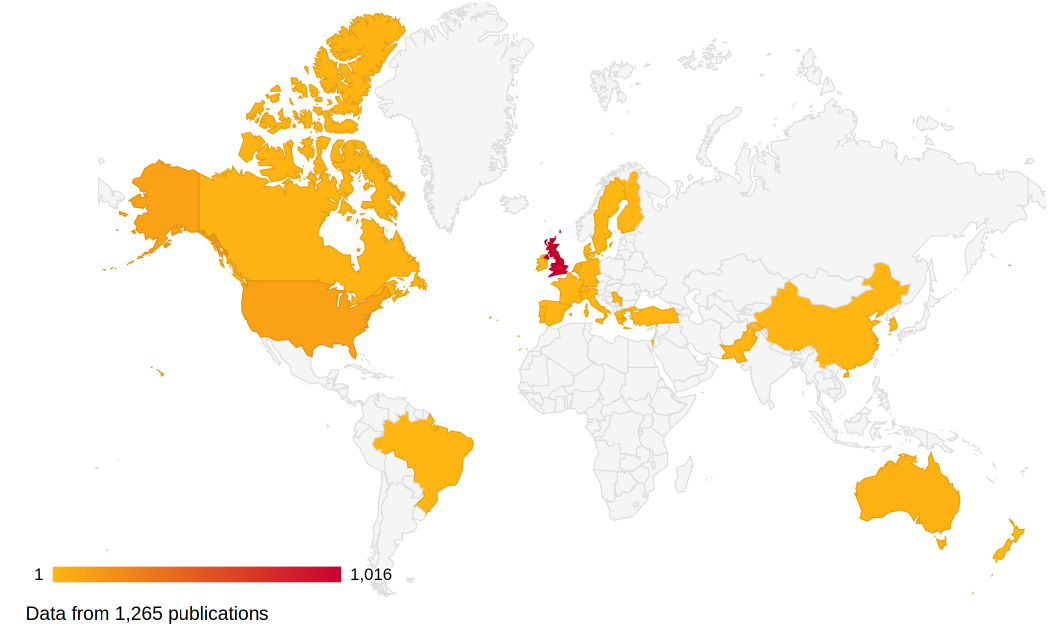
Figure 4. Choropleth map of first author countries in